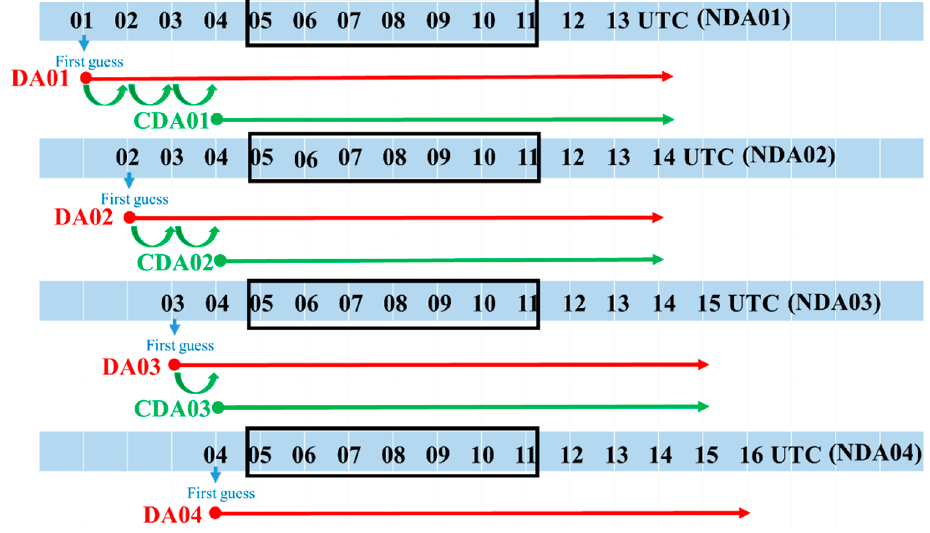
Figure 3. Schematic diagram of data assimilation-forecast strategy for the 2-km mesh for experiments of C1(NDA01, NDA02, NDA03 and NDA04), C2(DA01, DA02, DA03 and DA04) and C3 (CDA01, CDA02 and CDA03). The black box represents the major impact period of the thunderstorm event. Table 1. Design of experiments.